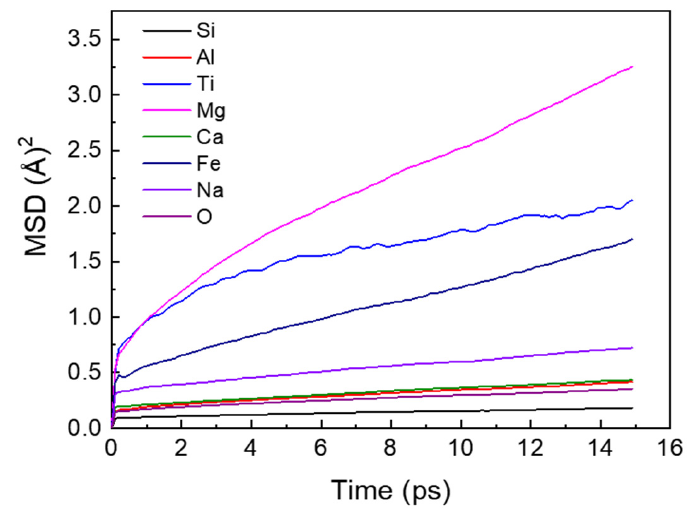
Figure 7. MSD curves for the #1 fused red mud system .